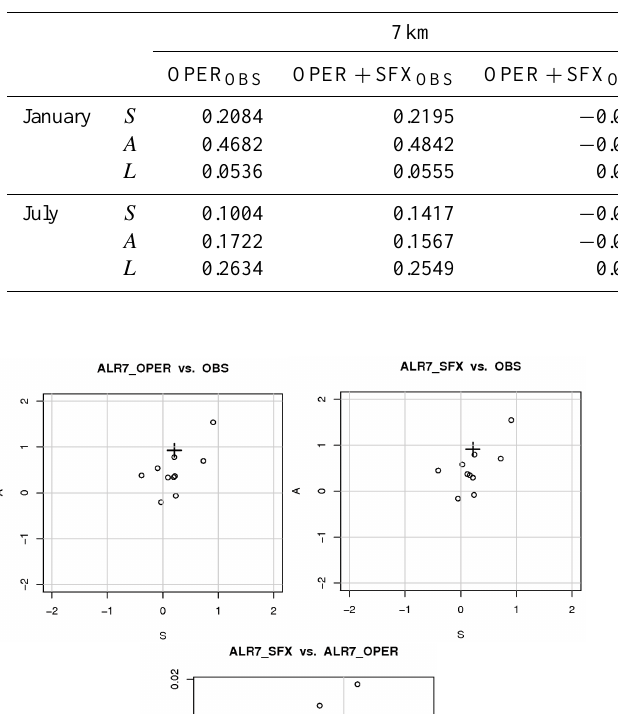
Table 6. The average (for January and July 2010) S (structure) A (amplitude) L (location) scores, for the 4km and 7km runs with (OPER + SFX) and without SURFEX (OPER) against radar observations. A third column is added for each run corresponding to the SAL scores for the run with SURFEX with respect to the operational run.